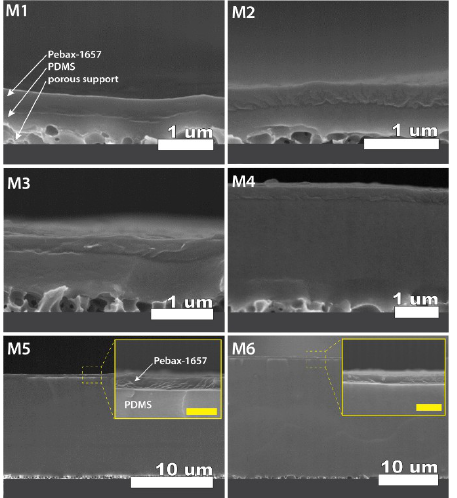
Figure 6. Cross-section scanning electron microscopy (SEM) images (acquired on Hitachi S-5200 FESEM, with accelerating voltage 5 kV) reflecting the morphology of different fabricated TFC membranes (codes indicated in each image). All membranes containing Pebax-1657 as selective (upper) layer, PDMS as a gutter layer (middle), and porous support (bottom) as indicated for membrane M1 . Insets of the cross-section show magnified views of the top Pebax-1657 layer (yellow scale bars = 1 µm). Numerical values of the thicknesses and measurement errors can be found in Table 2.